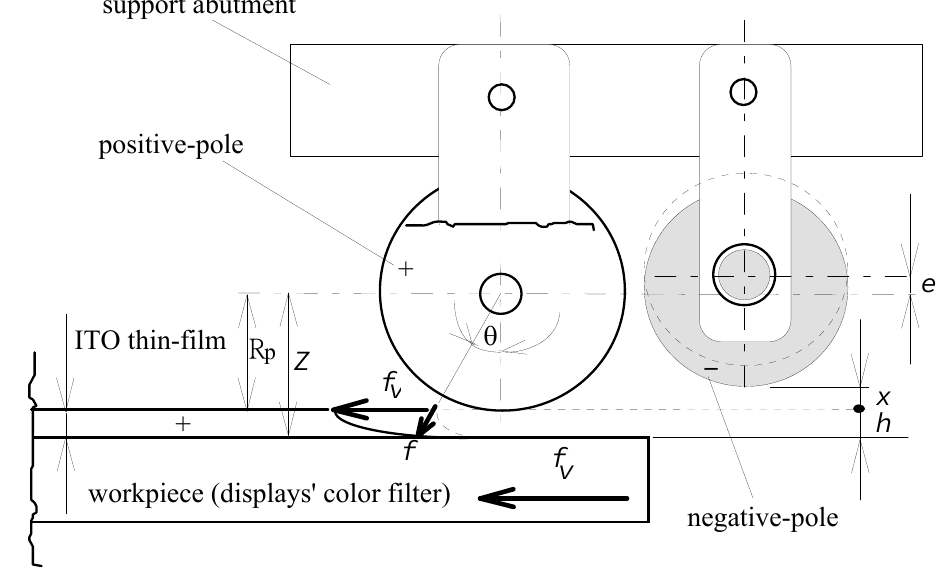
Figure 2. Configuration of electrodes and